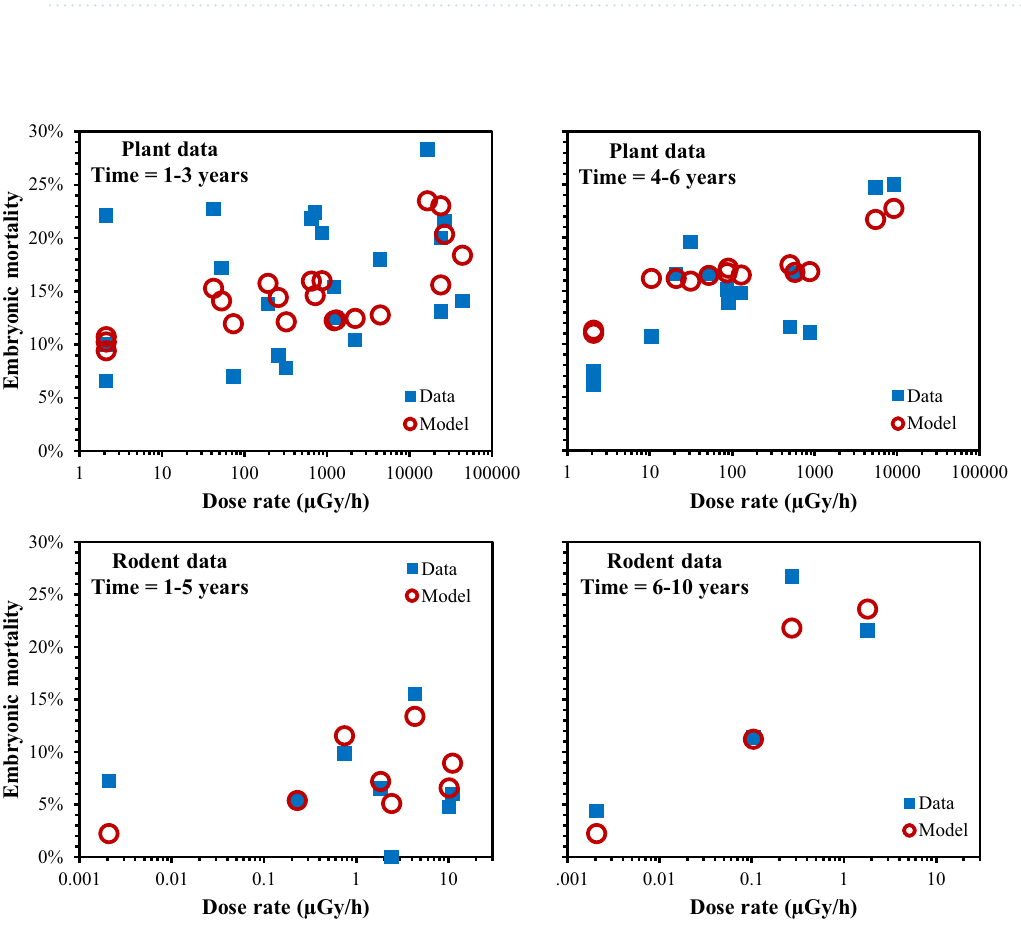
Table 2. Comparison of observed and fitted embryonic mortality in the rodent data set. R 2 for observed versus model-fitted values was 0.84, and RMSE was 0.029.